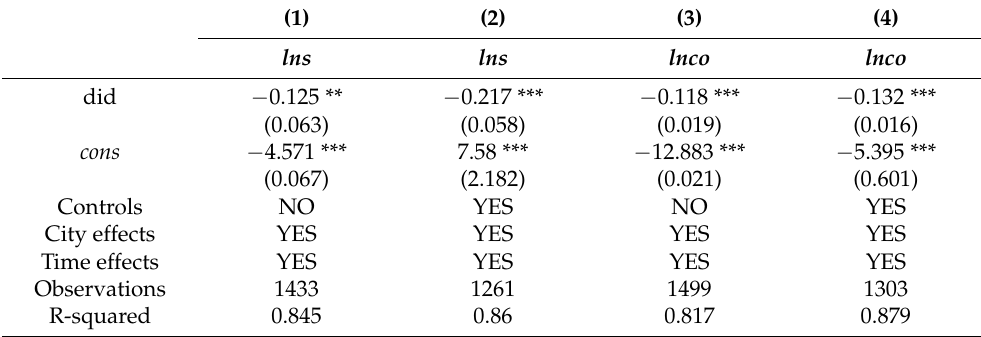
Table 7. HTZs to